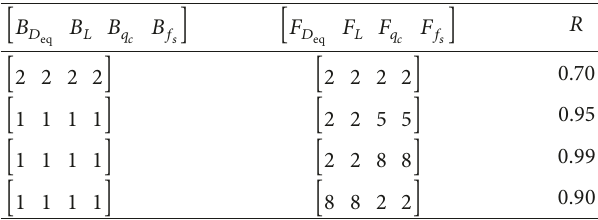
Table 4: Linear function order trails